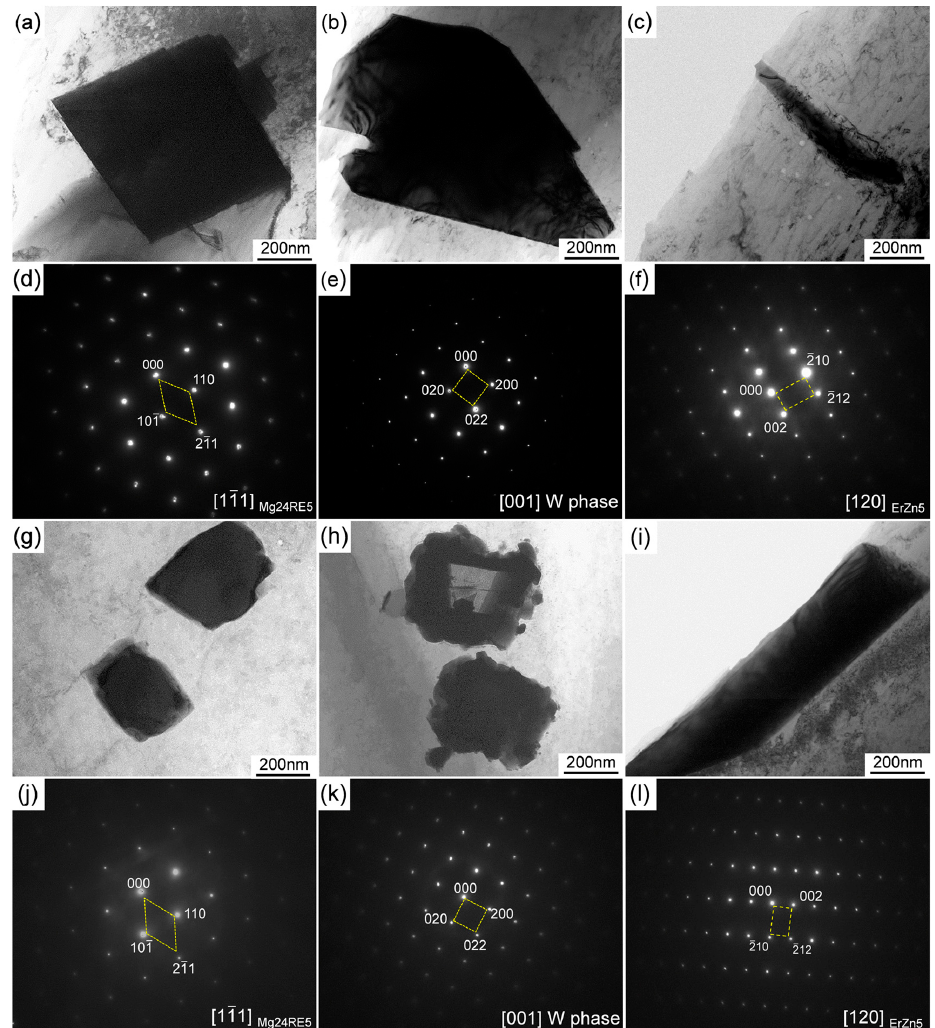
Figure 4. Bright-field transmission electron microscope (BF-TEM) images and corresponding selected area electronic diffraction (SAED) patterns of the intermetallic phases in the as-cast alloys: ( a – f ) Mg- 11Li-4Y-2Er-2Zn and ( g – l )